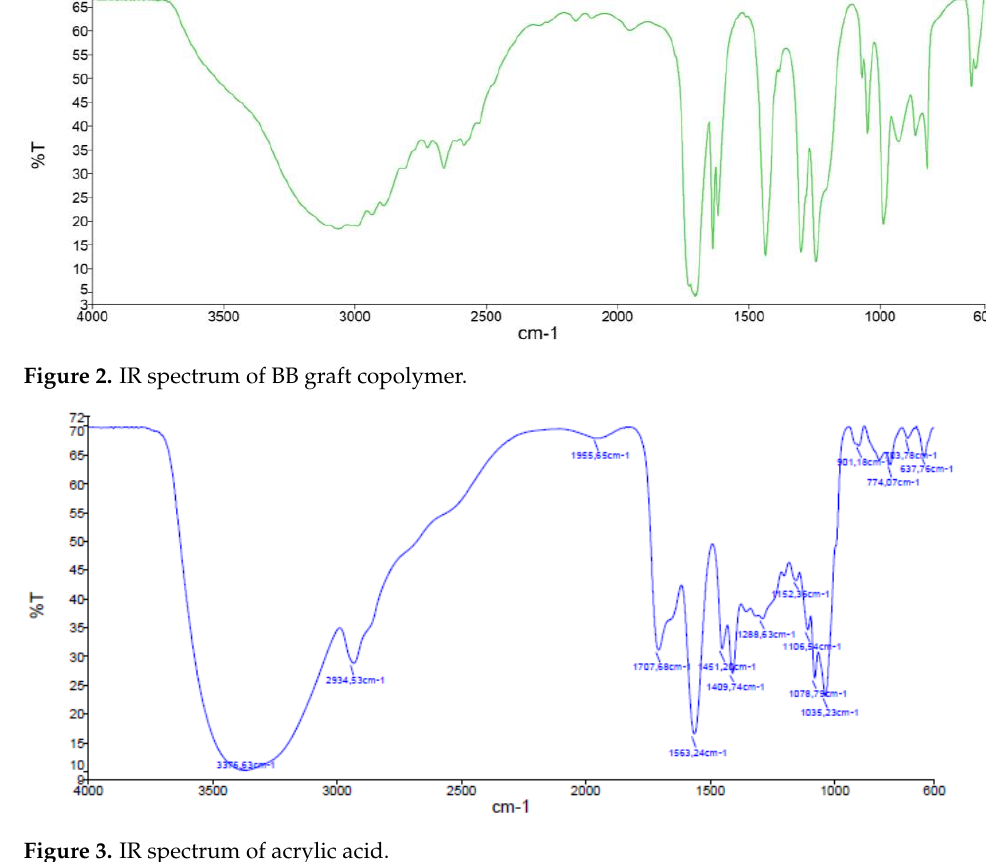
Figure 3. IR spectrum of acrylic acid.